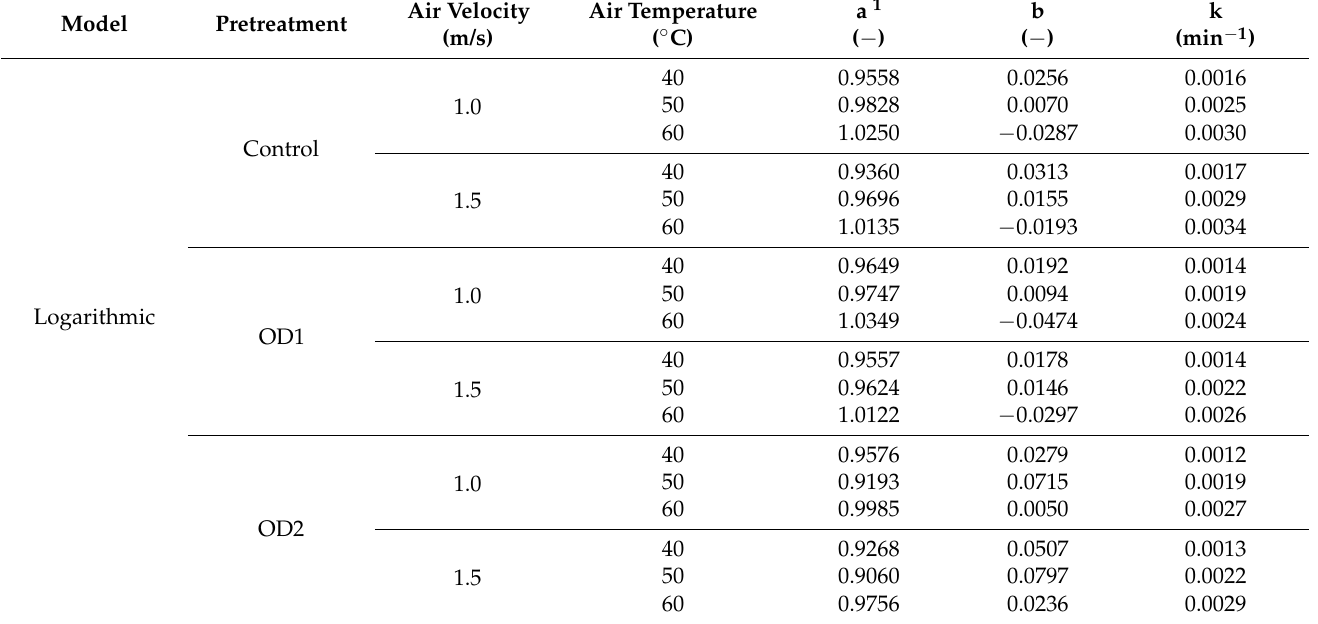
Table 6. The coefficients of Logarithmic model used to describe the kinetics of hot air drying of fresh and osmotically- pretreated apricot